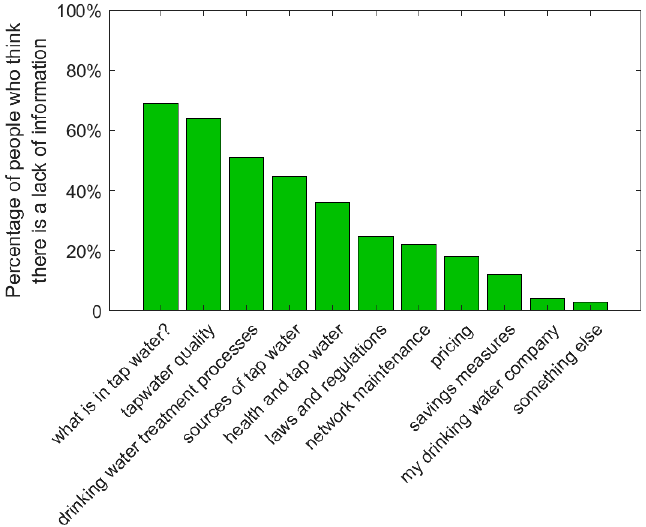
Figure 4. Topics customers would like to be informed about.